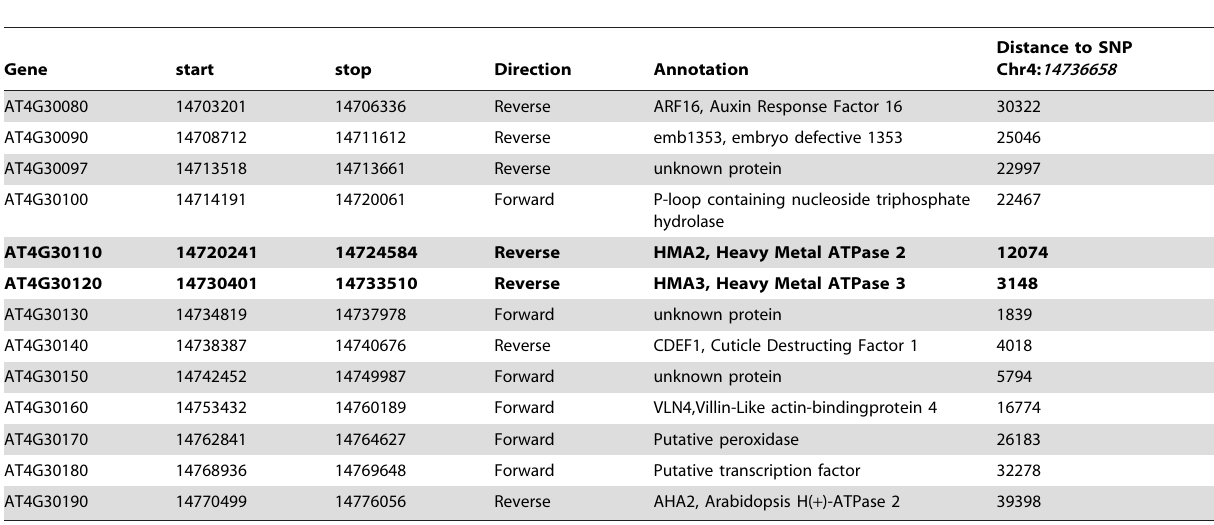
Table 1. Genes within 40 kb of the SNP most highly associated with leaf Cd.